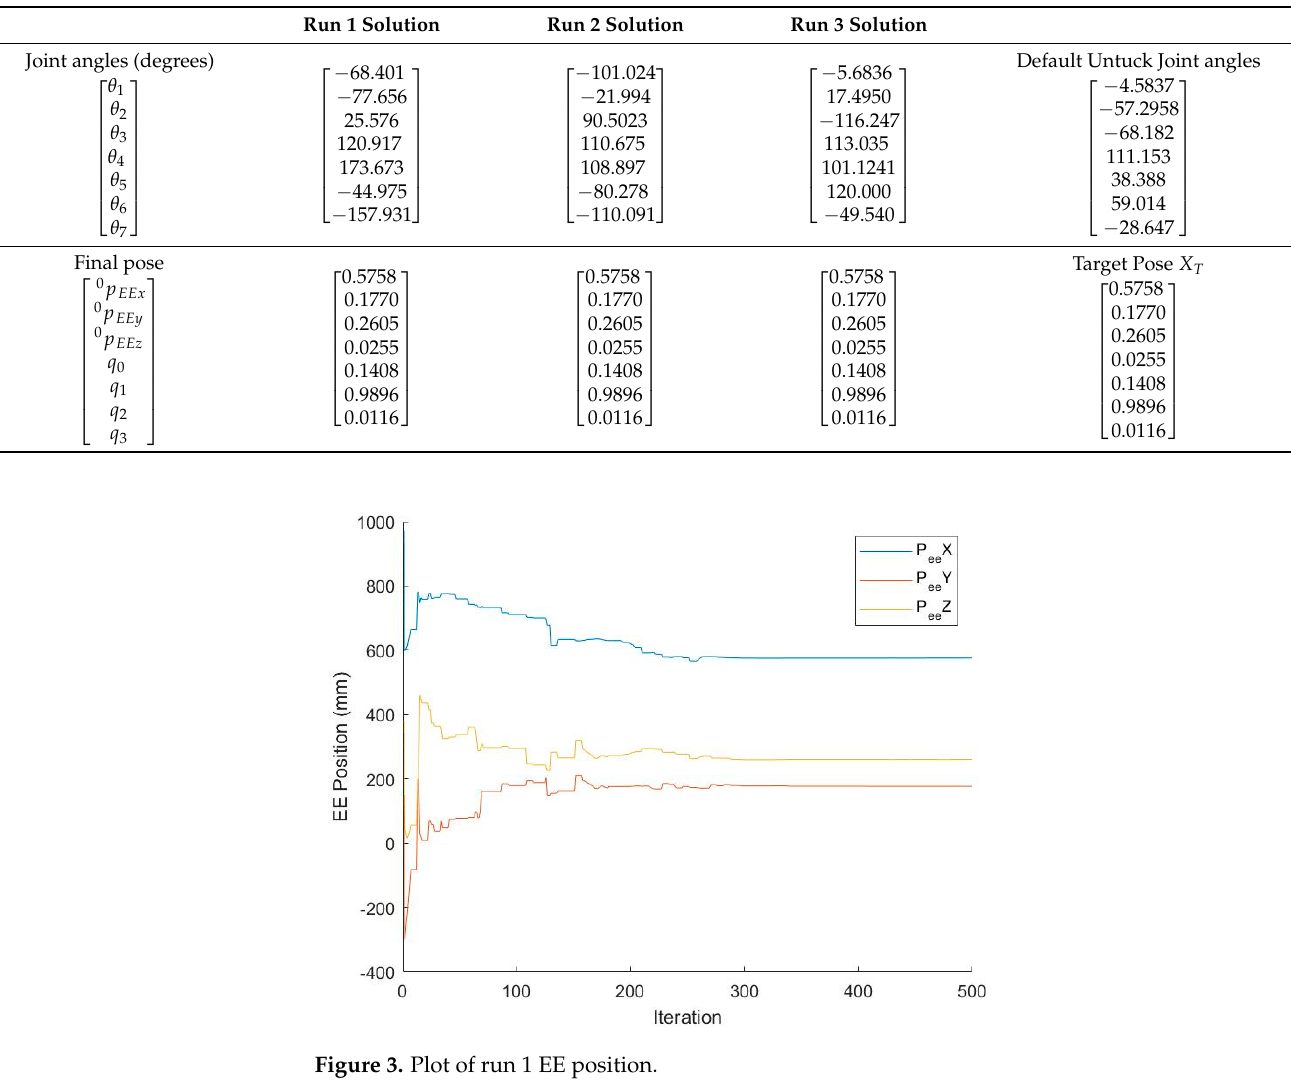
Figure 4. Plots of run 1 EE orientation.